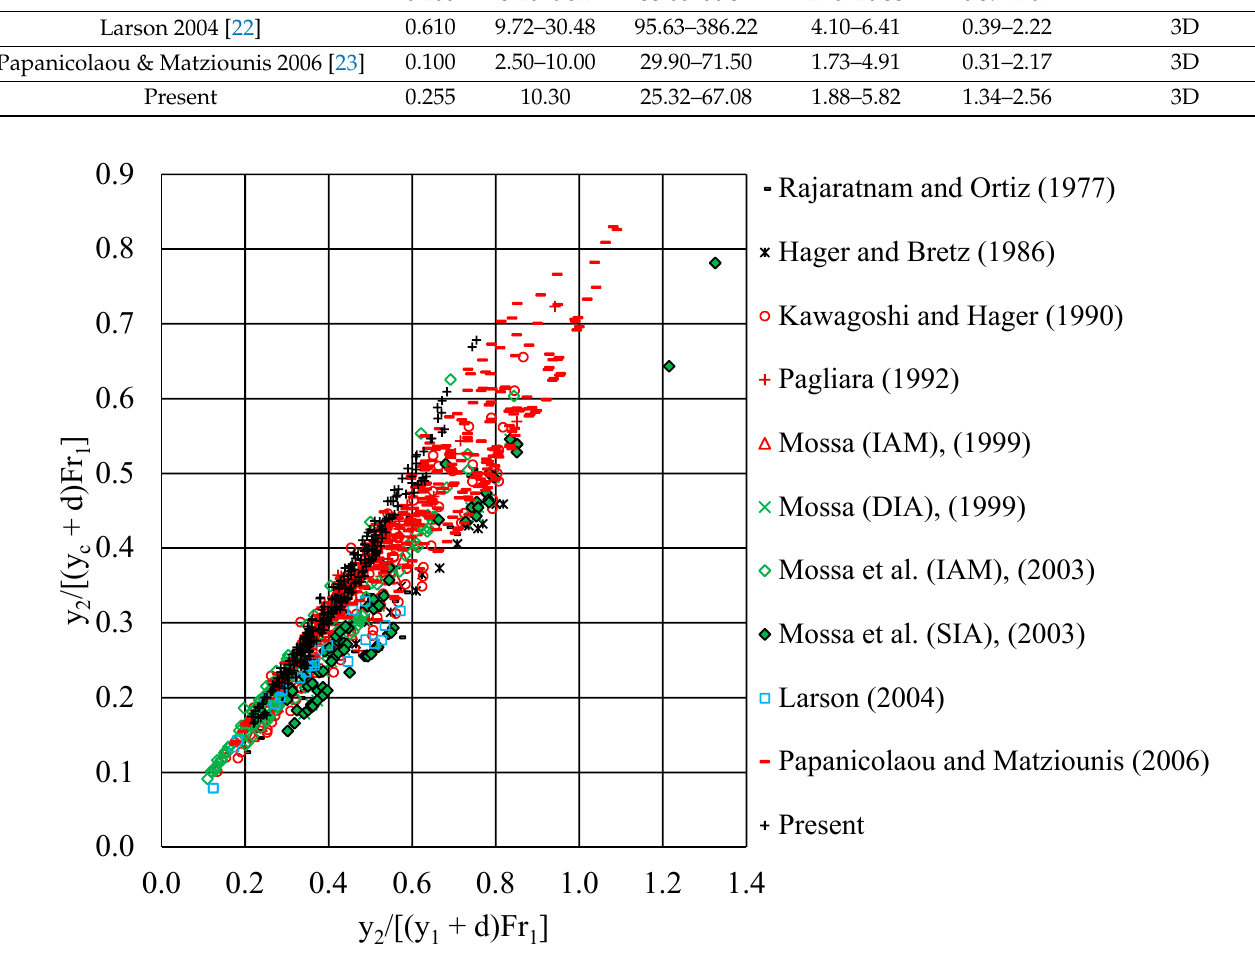
Figure 18. Comparison of y 2 /[(y c + d)Fr 1 ] versus y 2 /[(y 1 + d)Fr 1 ], from the present and earlier investigations [4,6,7,9,12,13,19,22,23]. The normalized energy loss computed from the one-dimensional energy equation with critical depth ∆ H/y c is a function of the dimensionless parameter Fr 1 (y c + d)/y 2 as shown in Figure 6. A quadratic equation can give an estimate of ∆ H/y c when the flowrate, step height, Froude number and tailwater depth are given. In Figure 19 we have plotted the present data along with data from earlier experiments for comparison. Data [4] show the same trend as the present ones and those in [22], while those by other authors have shown higher energy loss even in the regime 2 < Fr 1 (y c + d)/y 2 < 6 of the present data. From Table 4 one may note that the data with higher energy loss correspond to a two- dimensional type of flow where the open channel used was quite wide. The hydraulic jump is an energy loss mechanism where dissipation occurs due to vigorous mixing